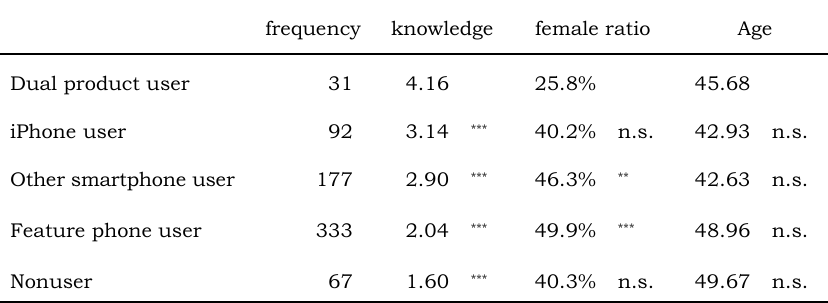
Table 1. The average of knowledge, female ratio and